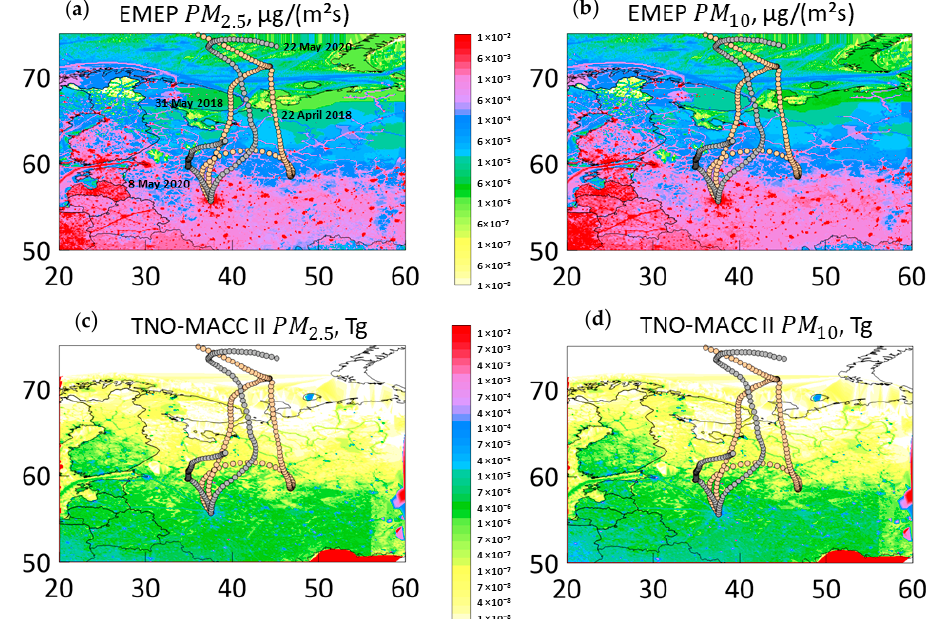
Figure 2. Annual anthropogenic emissions of PM 2.5 and PM 10 over Europe from EMEP database for 2009 (( a , b ), in µ g/(m 2 s)) and TNO-MACC II database for 2017 (( c , d ), in Tg per year). The lines are the backward trajectories from HYSPLIT model at 500 m above ground for NWP cases (12 UTC of each